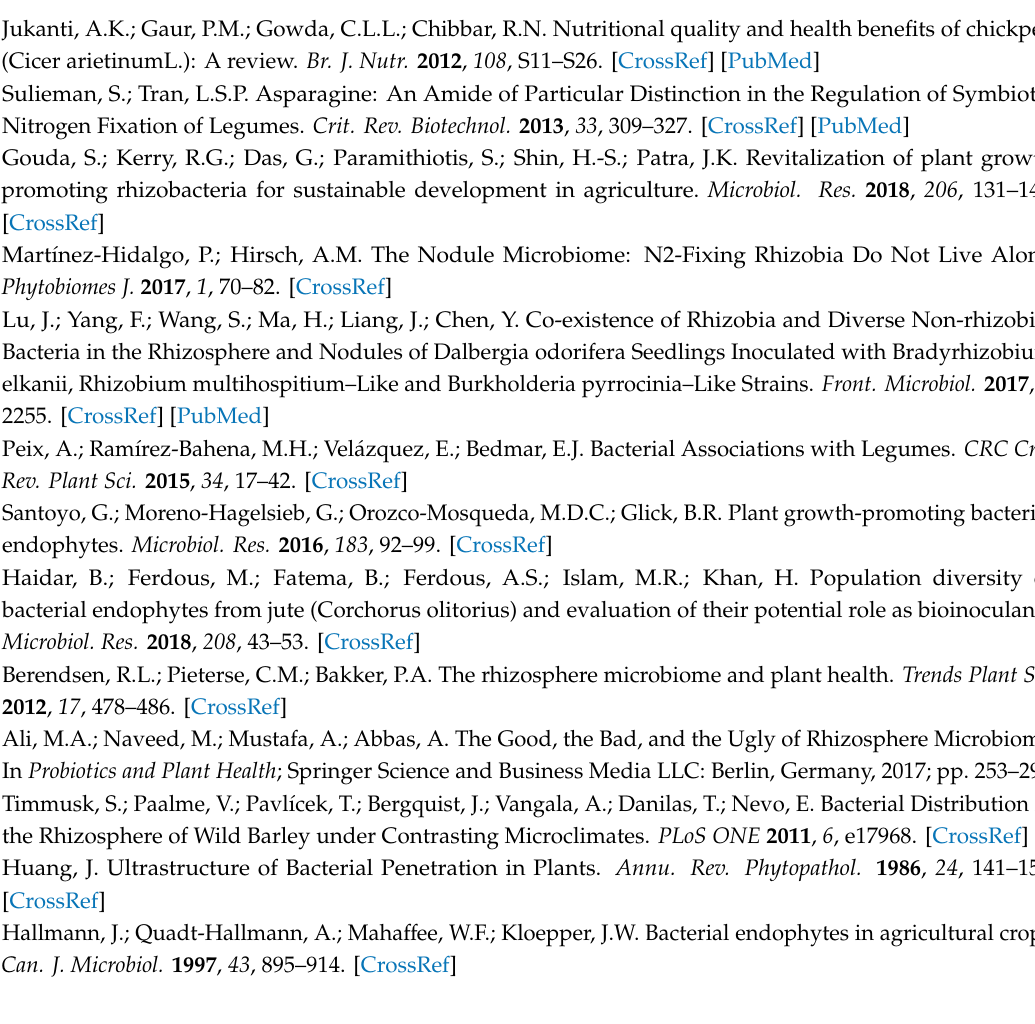
Table S1: Colony morphological characteristics of endophytic strains from chickpea grown on yeast extract mannitol